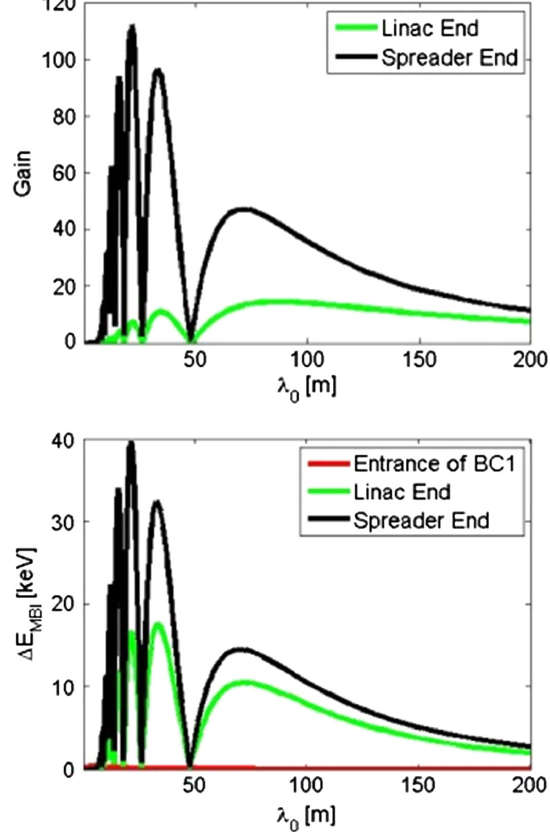
FIG. 5. Gain (top) and energy modulation amplitude (bottom), at the end of the FERMI linac (green) and of the linac-plus- spreader beam line (black). The laser heater is set at 10 keV rms energy spread before compression. The bunching factor (not shown) grows up to 0.4 in the wavelength range 10 – 50 μ